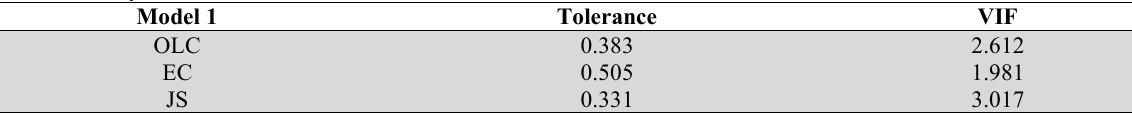
Multicollinearity